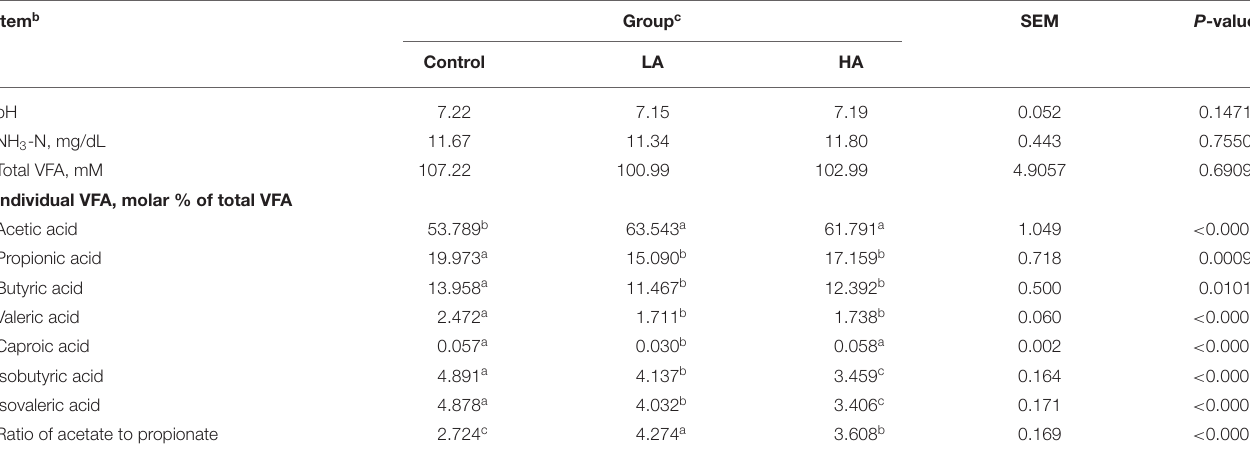
TABLE 4 | Effect of purple corn anthocyanin on ruminal fluid fermentation parameters of dairy goats a . Item